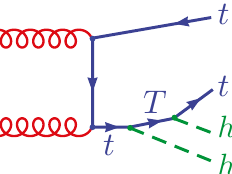
Figure 16 . Example diagram for the Yukawa mediated single T contribution to tthh .